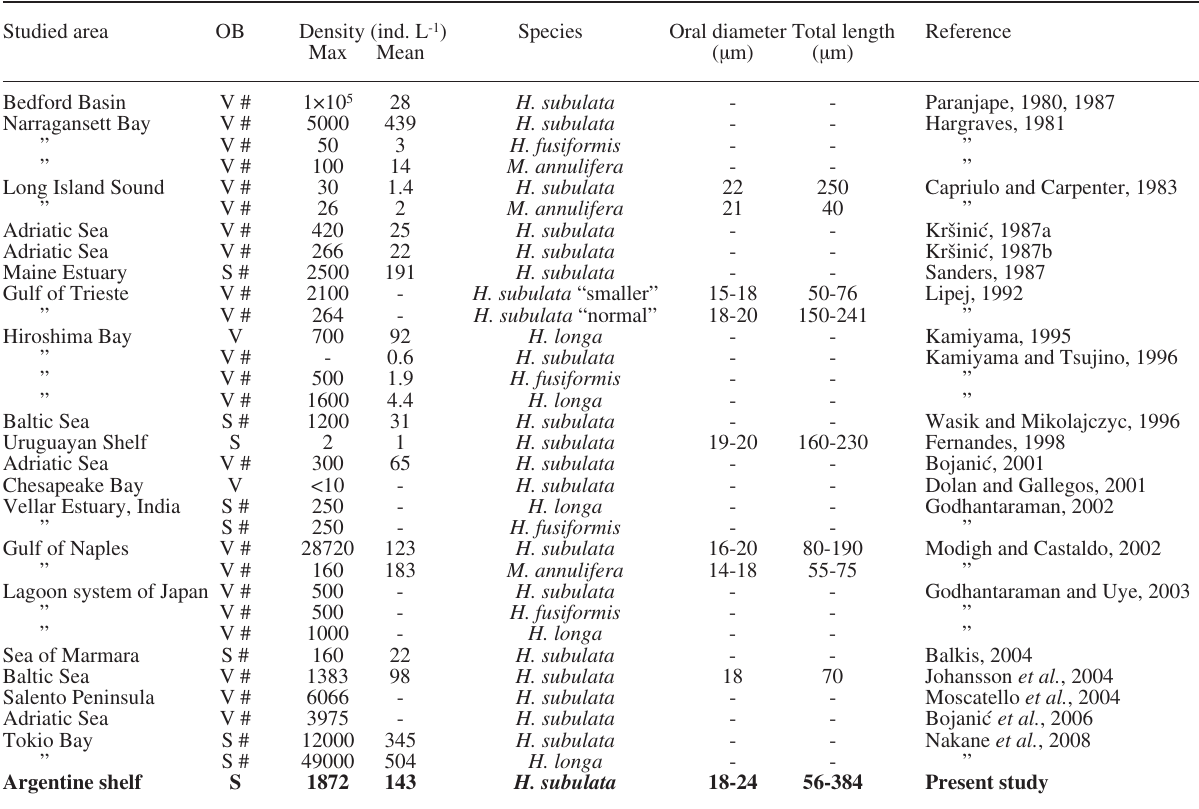
Table 5. – densities of Helicostomella spp. and metacylis annulifera reported by previous ecological surveys. When not provided, mean densities were estimated on the basis of information given by the authors. observations (oB): studies which covered vertical distribution (V) or only surface/ sub-surface waters (S) and annual cycles